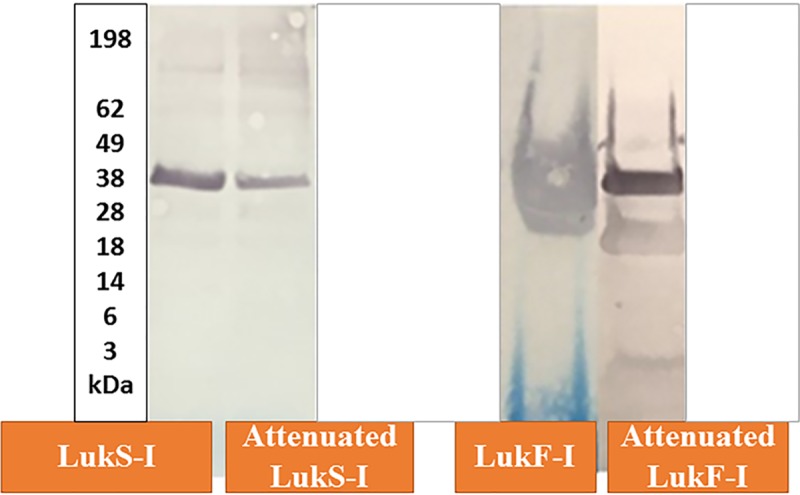
Western blot of recombinant S. pseudintermedius wild-type and attenuated LukS-I and LukF-I with HRP-conjugated anti-6xhis tag monoclonal antibody.The Molecular weights of LukS-I, LukF-I, attenuated LukS-I and attenuated LukF-I determined in western blots using pre-stained Protein Standard (x 1,000) were of the expected sizes 39.43, 39.12, 37.27 and 37.59 kDa, respectively.